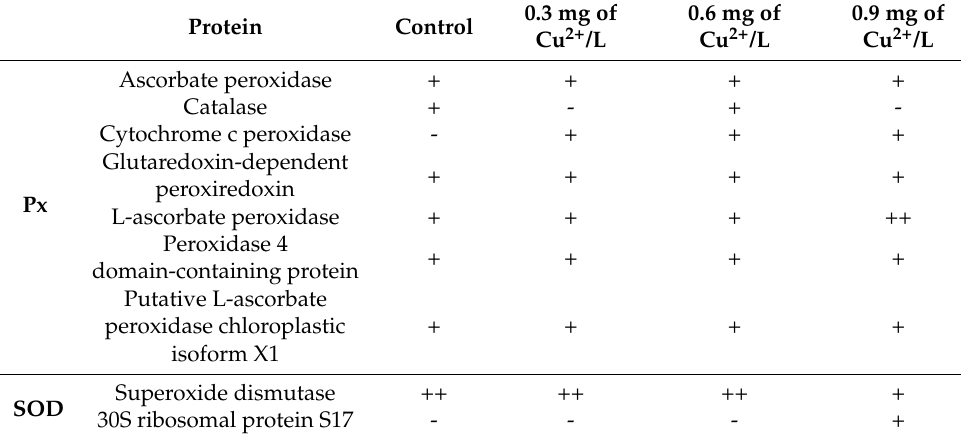
Table 3. Identified proteins related to antioxidant activity including Px and SOD.